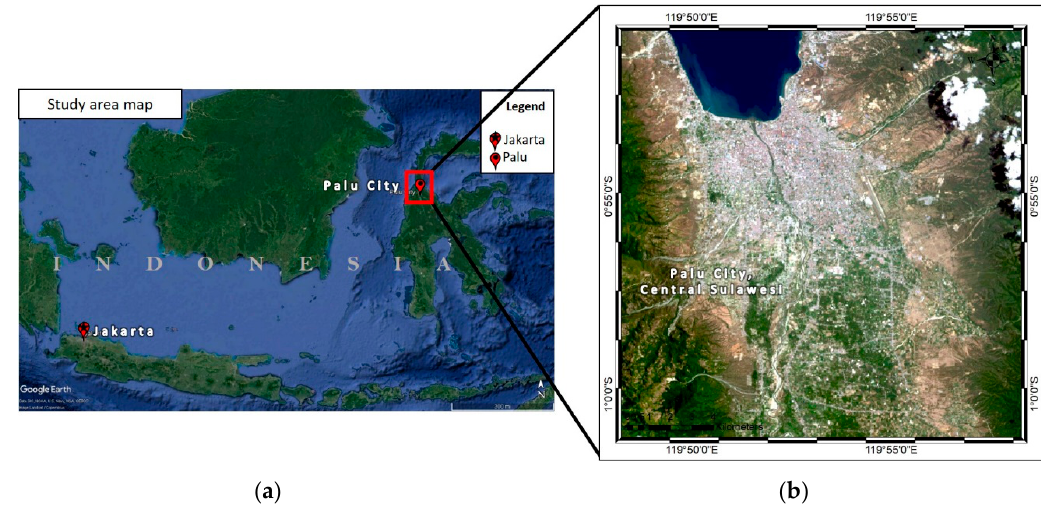
Figure 1. Map of Palu, Central Sulawesi Province, Indonesia, where the highest level of damage occurred as a result of the 2018 earthquake: ( a ) location of Palu in relation to Jakarta, the capital of Indonesia; ( b ) image of Palu from Landsat ‐ 8 data captured on 16 September 2018.